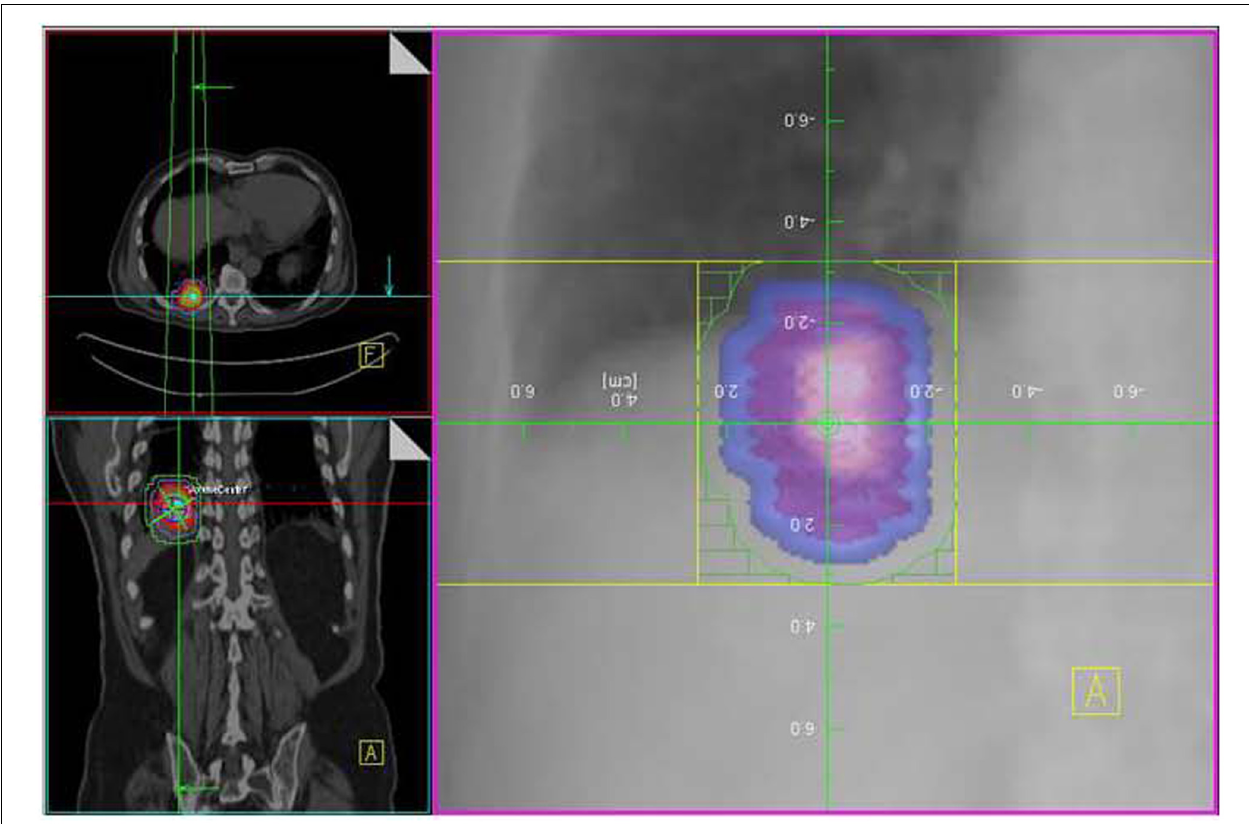
FIGURE 10 | Same patient as in Figure 4A with GTV (pink), CTV (blue), and PTV (green) drawn using a combination of end expiratory and end inspiratory metabolically active tumor volume as obtained from respiratory-gated